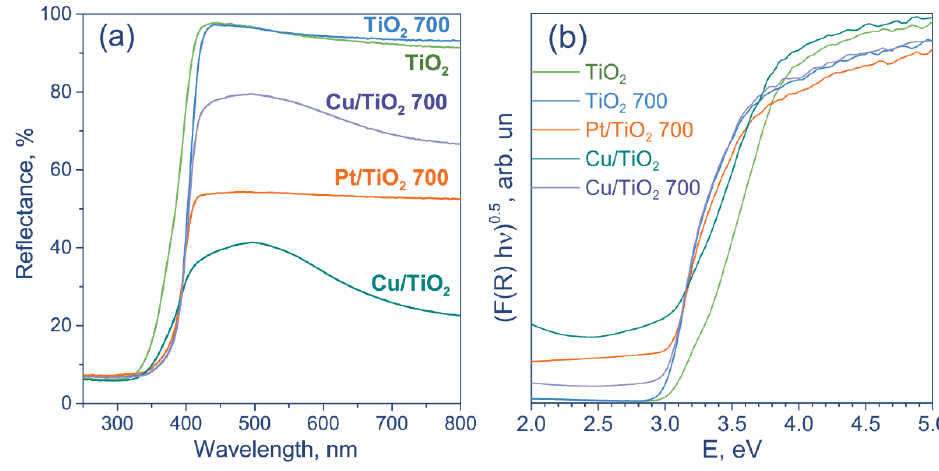
Figure 2. ( a ) Diffuse reflectance spectra of photocatalysts under study; ( b ) Tauc plots. The actual metal content established by ICP-AES was around 0.7% for platinized samples and 4.5% for Cu-containing